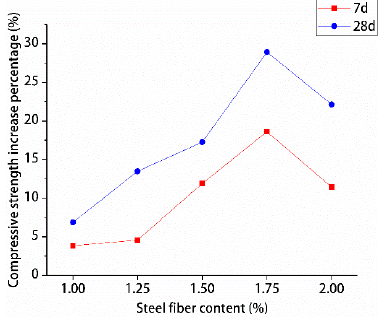
Figure 15. Increase percentage of compressive strength. Materials 2020 , 13 , x FOR PEER REVIEW